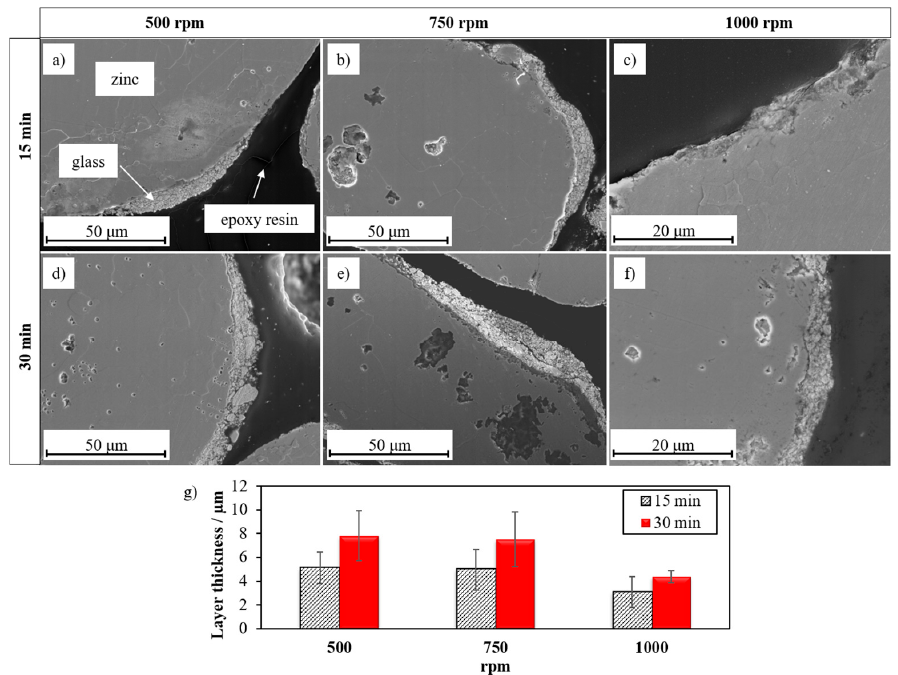
Figure 4. SEM micrographs (secondary electrons) of the cross sections of glass-coated 250 μ m zinc granules coated under the following conditions ( a ) 500 rpm, 15 min ( b ) 750 rpm, 15 min ( c ) 1000 rpm, 15 min ( d ) 500 rpm, 30 min ( e ) 750 rpm, 30 min, ( f ) 1000 rpm, 30 min. ( g ) Layer thickness on dependency of rotational speed and coating time.